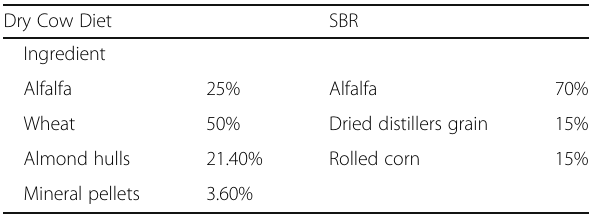
Table 3 Composition of dry cow diet and super basic